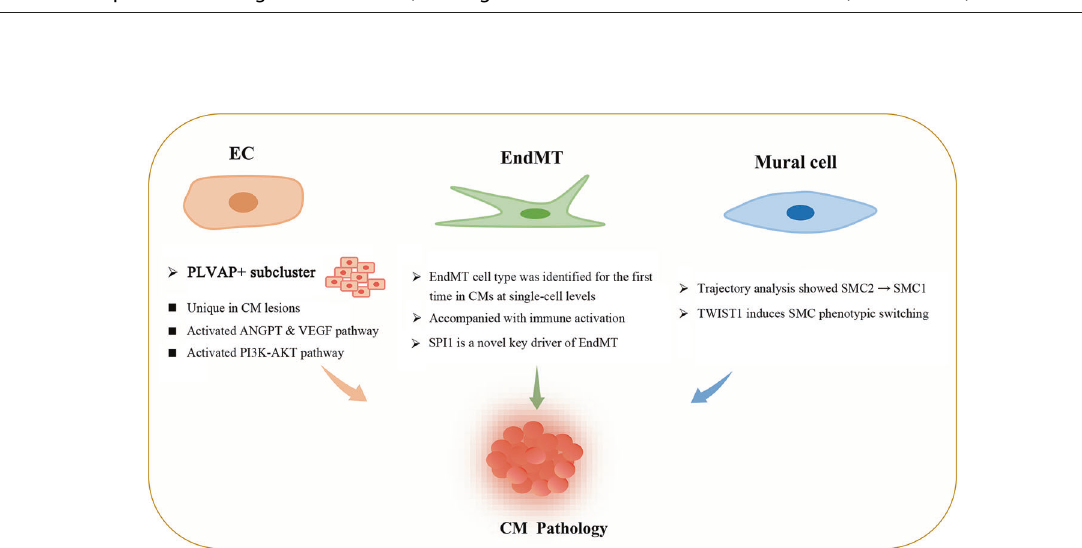
Fig. 7 TWIST1 induced phenotypic switching of SMCs. a SCENIC-based tSNE plot for the distributions of SMC1 and SMC2. b SCENIC analysis predicted the transcription factor TWIST1 as a speci fi c hub distinguished from SMC2 governing SMC1 cell states (left panel). TWIST1 regulon activities were quanti fi ed using AUCell (right panel). c Dot plot for TWIST1 expression in SMC1 and SMC2. d TWIST1 target gene set scores in 11 cell types. Speci fi c genes are shown in Supplementary Table 5. e Expression levels of TWIST1 and SMC phenotypic switching markers analyzed via RT ‒ qPCR assay in HASMCs after TWIST1 and control plasmid transfection. f Morphological changes and cytoskeletal reorganization of HASMCs are shown by rhodamine-phalloidin staining (red) in the TWIST1 overexpression and control groups. DAPI-stained nuclei are shown in blue. Scale bars, 25 µm. g TWIST1 overexpression in SMCs of mice was induced by stereotaxic injection of AAV-SPI1 with the SM22a promoter into the basal ganglia. Primary cerebrovascular SMCs were collected 7 days after AAV-TWIST1 and AAV-vector injection. h Expression levels of Twist1 and SMC phenotypic switching markers analyzed via RT ‒ qPCR assay in primary SMCs of cerebrovascular after AAV-TWIST1 and AAV-vector injection. Primary SMCs were isolated following the standard procedure of the MicroBeads kit and then used for RNA extraction and RT ‒ qPCR assay without culturing. Data are represented as the mean ± SD (AAV-vector group, n = 6; AAV-TWIST1 group, n = 8). Statistics were performed using Student ’ s t test, and signi fi cance was determined as ** P < 0.01, *** P < 0.001, **** P < 0.0001.